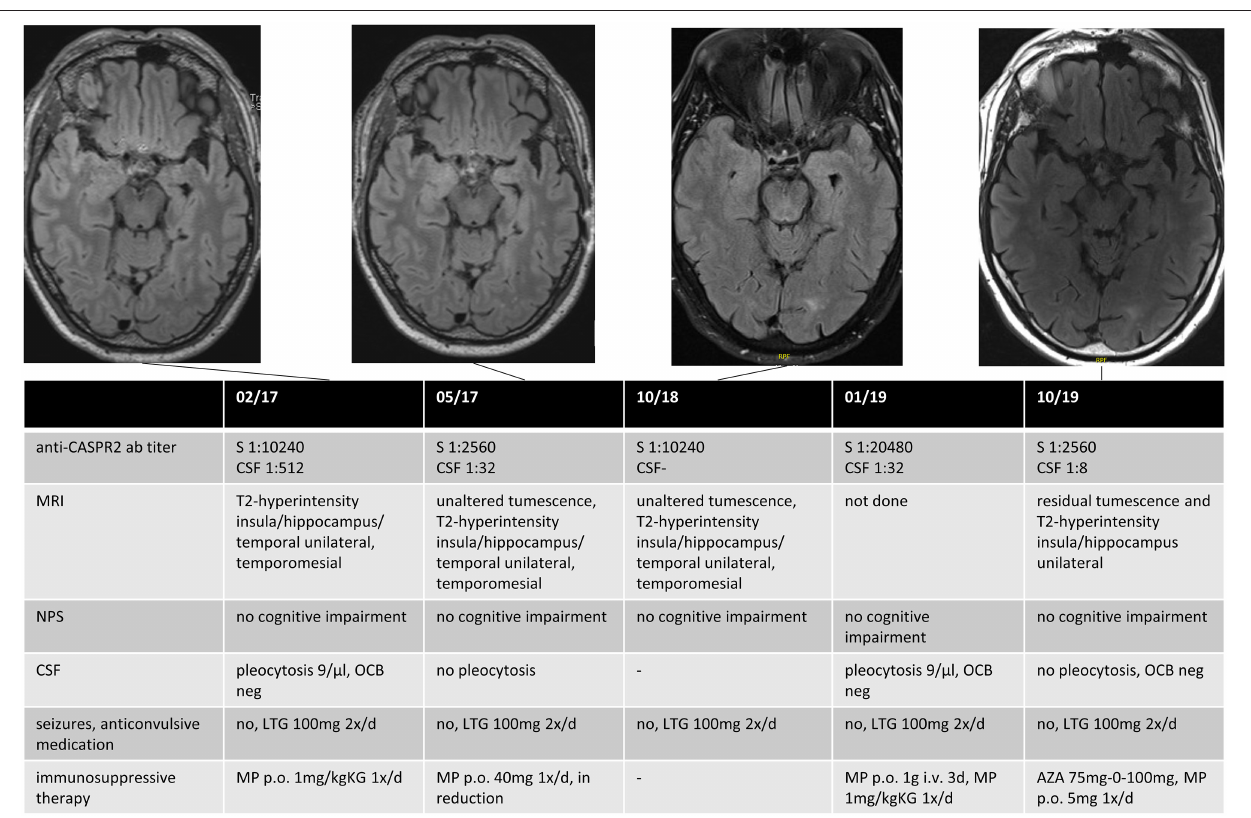
FIGURE 1 | Data for an anti-CASPR2 AB positive patient. The patient had a first epileptic seizure (GMS) 3 months before the diagnosis and recurrent focal seizures until he received monotherapy with Lamotrigin, after which he became seizure-free. The first MRI showed unilateral swelling and T2-hyperintensity in the insula, the hippocampus, temporal mesial, and in the temporal lobe, compatible with possible AE, although not fulfilling the Graus criteria in the absence of neurocognitive or neuropsychiatric deficits. Immunotherapy was initialized after positive testing for anti-CASPR2 AB in serum and CSF. The patient had no clinical signs of AE until last FU; immunotherapy was reinitialized 2 years after diagnosis because of an increased titer of anti-CASPR2 AB in routine clinical FU and a recurrent pleocytosis in CSF. Anti-CASPR2 contactin-associated protein-like 2, GMS generalized motor seizure, MRI magnet resonance imaging, AE autoimmune encephalitis, CSF cerebrospinal fluid, FU follow-up, S Serum, NPS neuropsychological testing, OCB oligoclonal bands, LTG Lamotrigin, MP Methylprednisolon, AZA